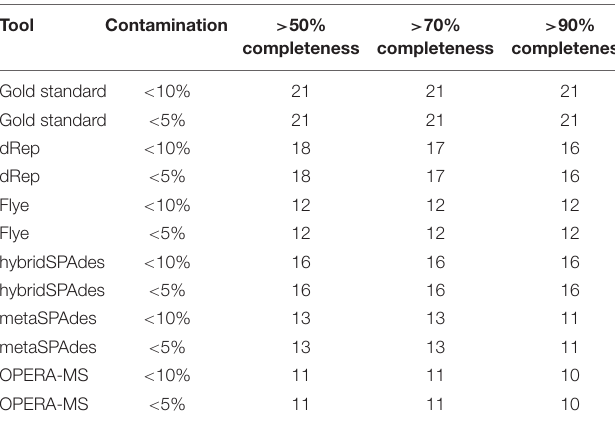
TABLE 5 | Respective numbers of genomes recovered from mock community (BMS21) dataset with less than 10 and 5% contamination and more than 50, 70, and 90%